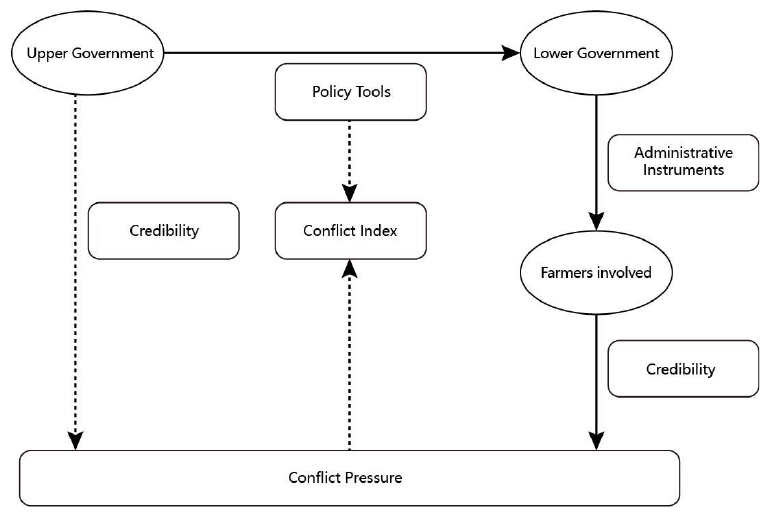
Figure 2. Schematic diagram of the implementation of the MVLT and conflict